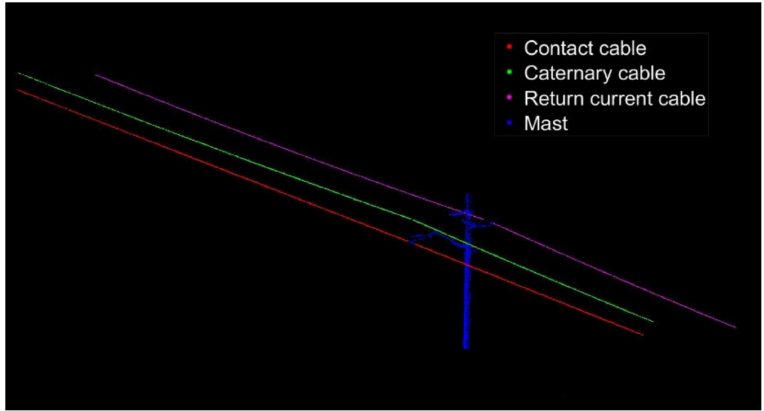
Figure 18. The result of 50 m OCS point cloud classification by TerraSolid.